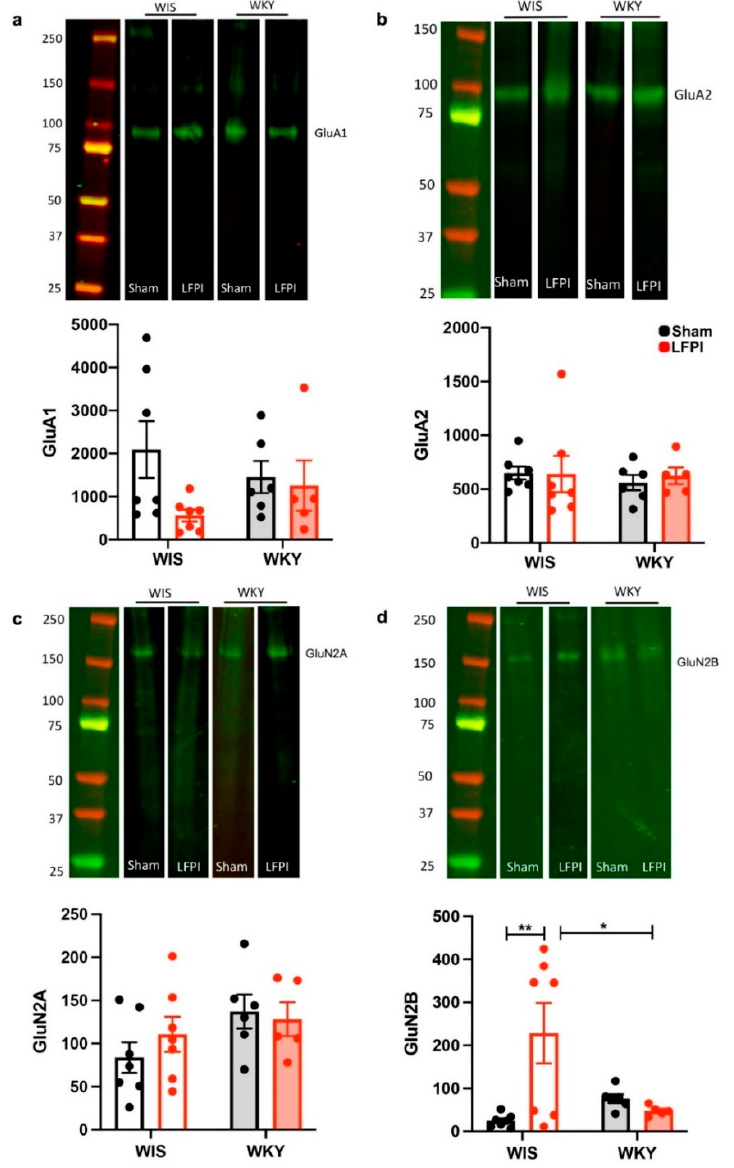
Figure 3. Changes in glutamate receptor subunit expression after injury, normalized to the total protein stain. ( a ) A representative selection of immunoblotting shows GluA1 protein expression